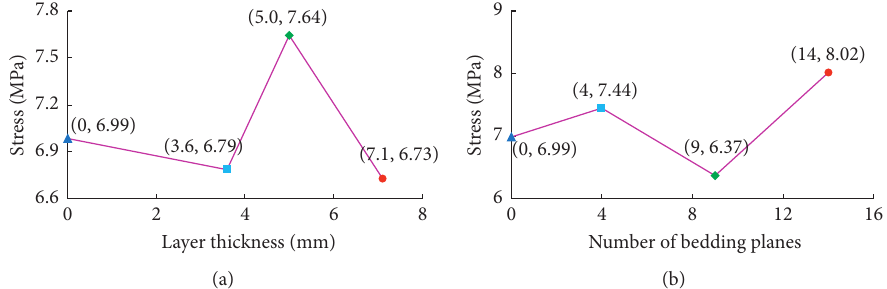
Figure 24: Tensile strength changes at the center of bedding models with different layer thicknesses. (a) Uniformly parallel. (b) Unevenly parallel.